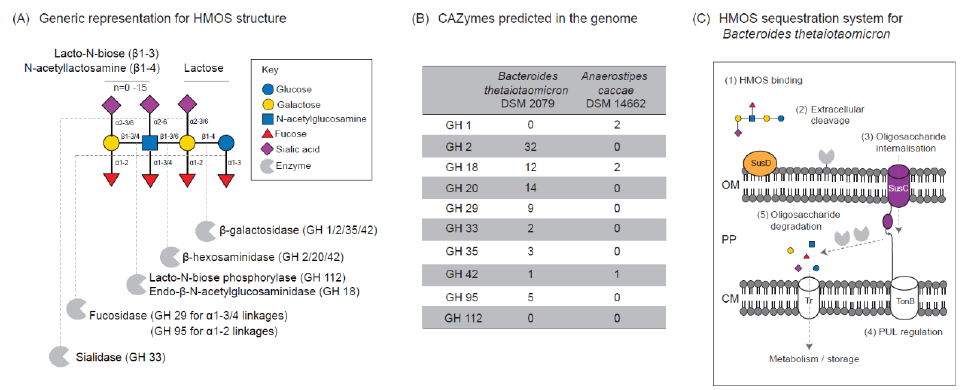
Figure 4. B. thetaiotaomicron degraded lactose and HMOSs in the co-culture. ( A ) A generic representation of HMOS structure [46] and prediction of bacterial glycosyl hydrolase (GH) required to cleave the